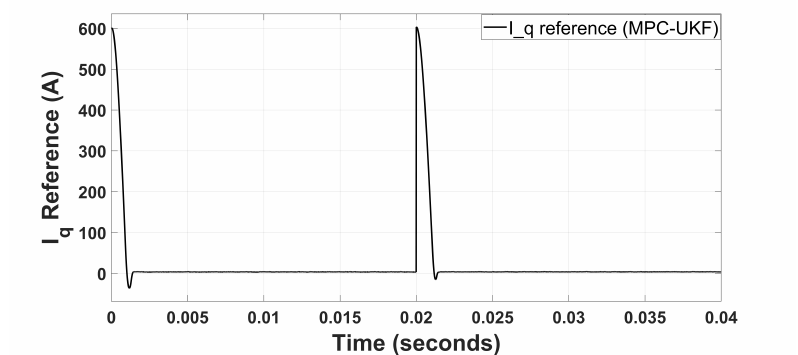
Figure 8. Reference current for